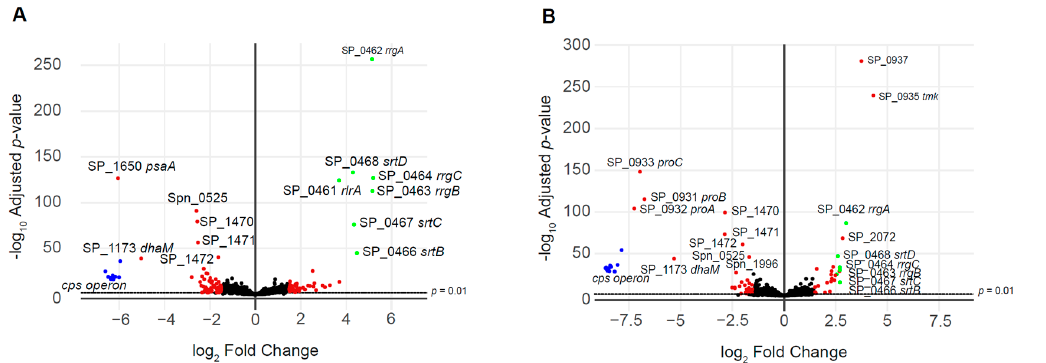
Figure 3. Volcano plots showing differential expression of genes in the live attenuated strains. Log 2 ratio gene expression levels for the mutant strains ( A ) ∆ cps/psaA and ( B ) ∆ cps/proABC compared to the wild type strain. Fold change expression is represented in the X-axis, with negative values indicating genes that are under-expressed in the mutant versus the wild type, while positive fold change values indicate genes that are over-expressed in the mutant versus the wild type. The Y-axis shows the p values (as -log 10 values) for differentially expressed genes. Genes belonging to cps locus are shown in blue, while those belonging to the pilus are shown in green, other genes that are differentially expressed are represented in red and all other genes are represented in black. Differential gene expression and statistical significance were analysed using the DESeq2 method. The dashed line above the x axis marks the significance threshold of p = 0.01. A full list of the genes showing differential expression with their expression levels is shown in Table S2, with selected genes of interest shown in Table 1.